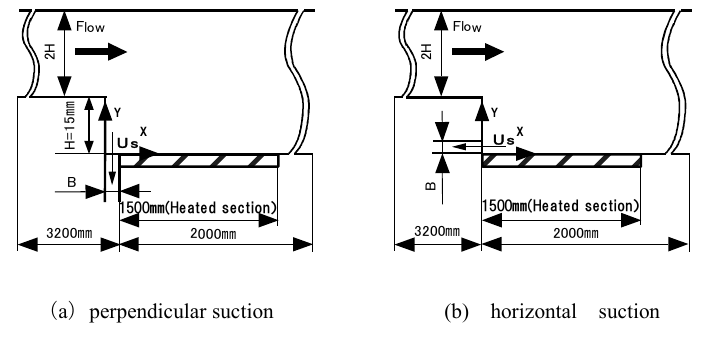
Fig.1 Schematic diagram of test